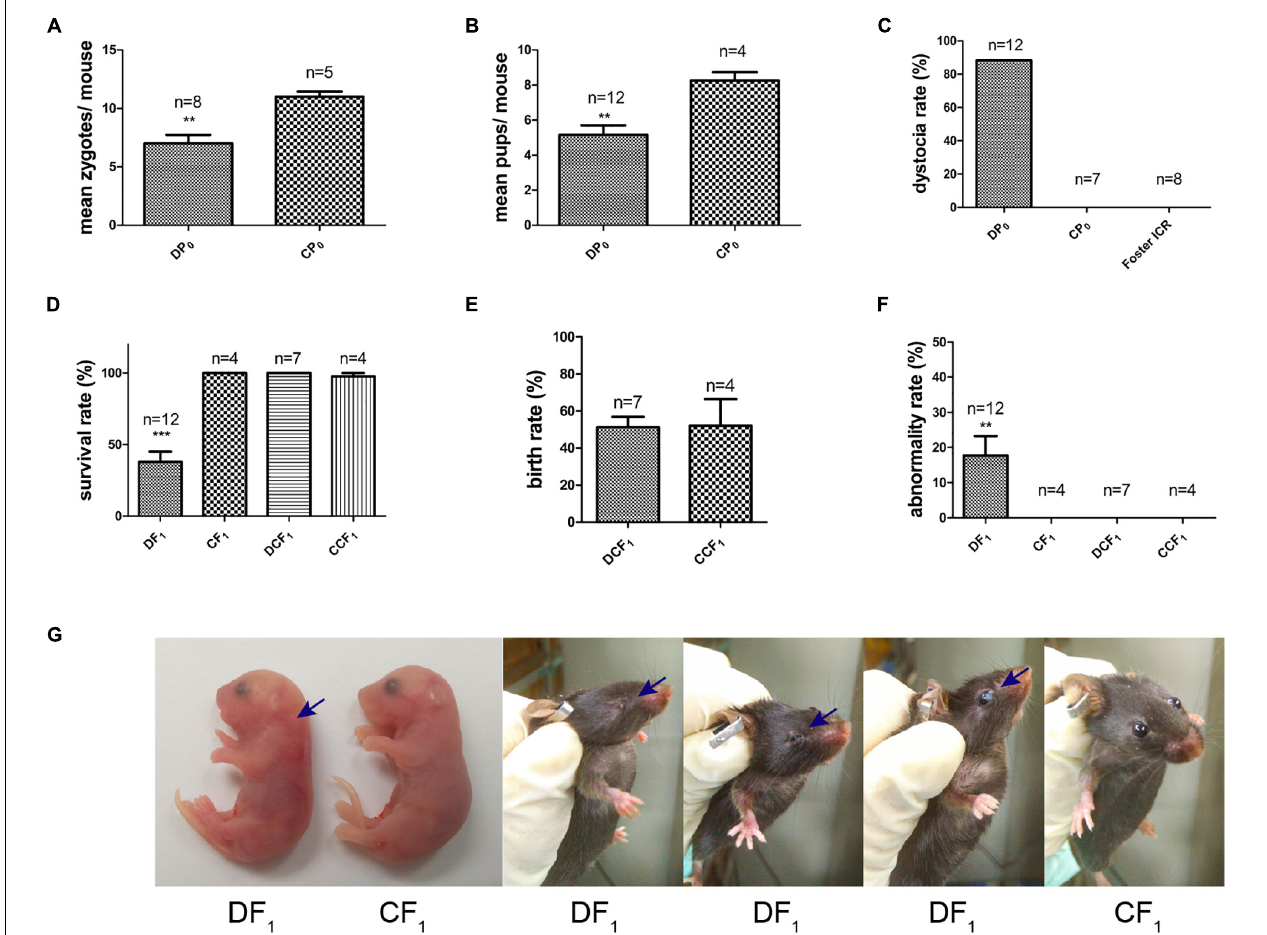
FIGURE 3 | Maternal reproductive phenotypes and offspring symptoms. (A) The number of zygotes per mouse. (B) The number of pups per mouse. (C) The maternal dystocia rate. (D) Survival rate of F 1 in each group. (E) Birth rate of DCF1 and CCF 1 . (F) Abnormality rate of F 1 in each group. (G) Congenital malformations of DF 1 compared to CF 1 . Blue arrows show abnormal regions. Data are expressed as mean ± S.E.M.; ** P < 0.01, *** P < 0.001 vs. CP 0 or CF 1 control. A two-tailed Student’s t -test was performed in (A,B,E) . The D’Agostino and Pearson omnibus normality test was applied in (D,F) . P -values for significance between groups in repeated measure analysis are